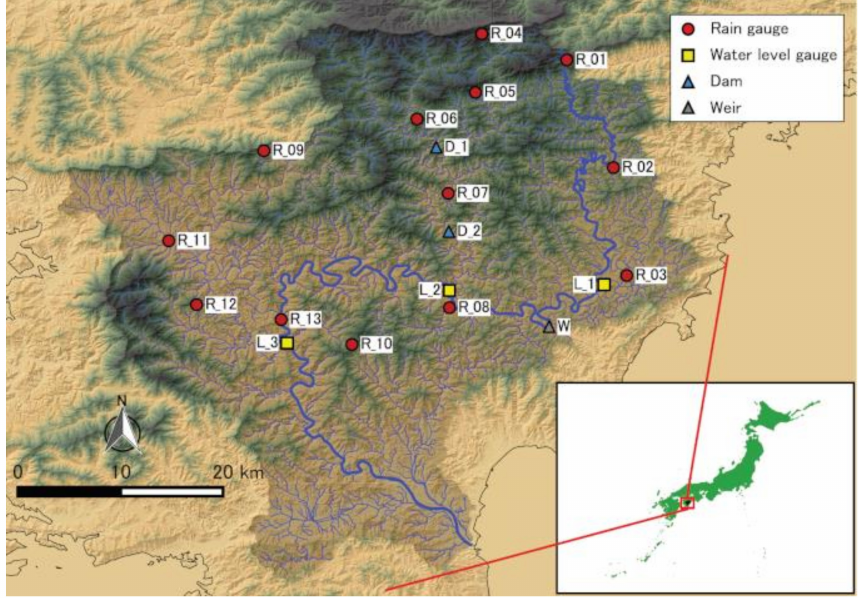
Figure 1. The Shimanto river watershed and location of rain gauges and stage observatories. Rain gauges are labeled R_01 to R_13. The stage observations are from L_3